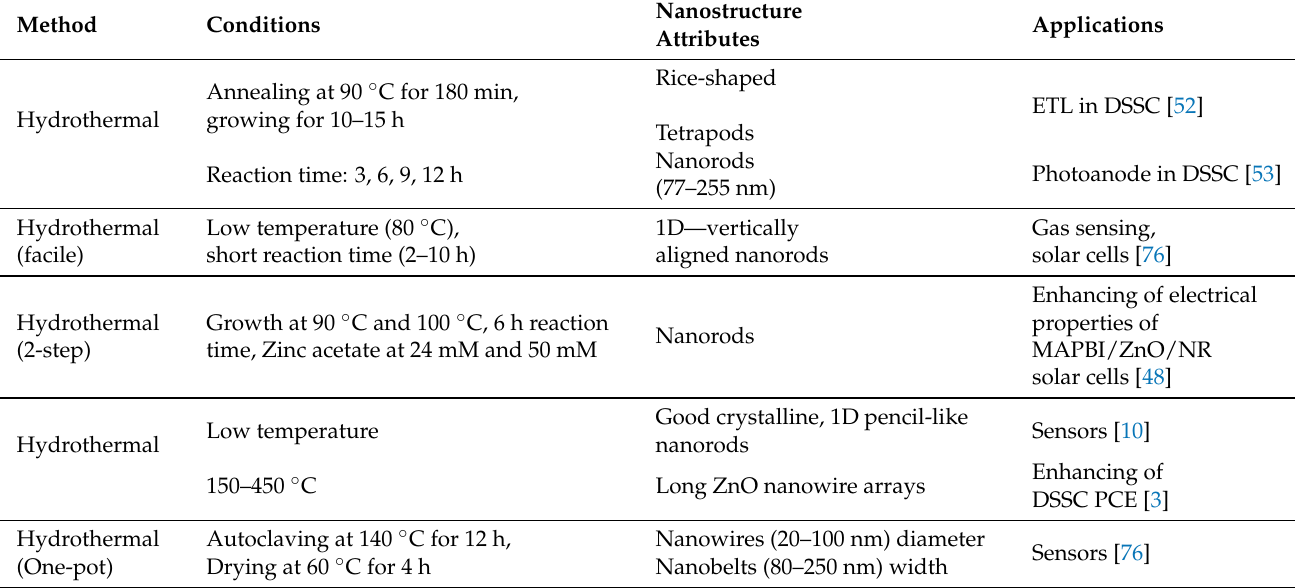
Table 3. A summary of the various ZnO synthesis methods, observed nanostructures, and reported